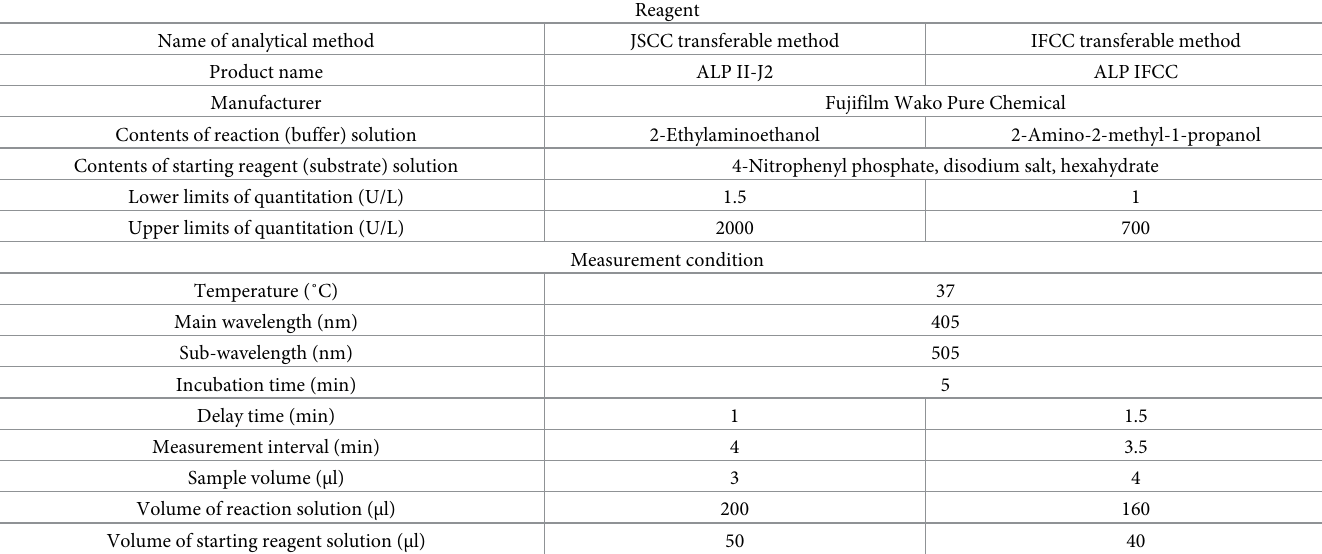
Table 1. ALP analytical reagents and measurement conditions in this